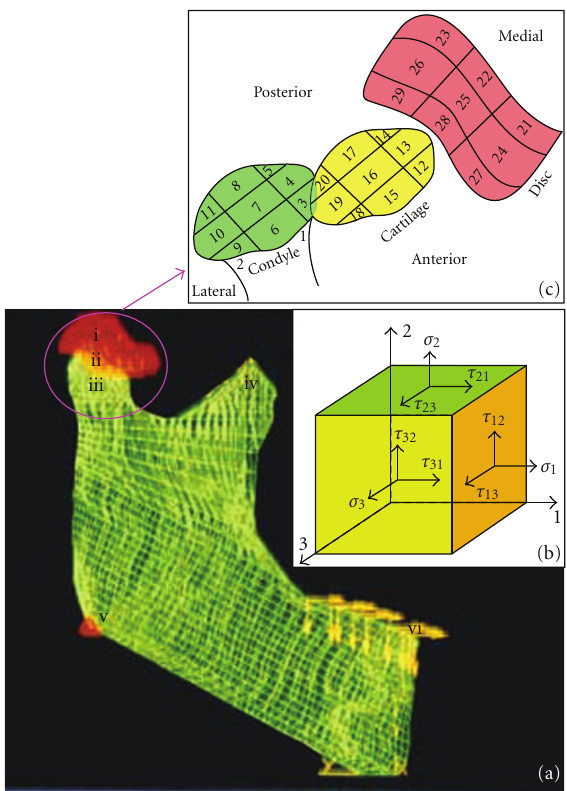
Figure 2: Finite element analysis model of temporomandibular joint (TMJ) stress. (a) Three-dimensional finite element mesh of the TMJ, including the mandible, disc (i), cartilage (ii), condyle (iii), and coracoid process (iv), with the mandible angle fixed (v) and alveolar ridge loaded by two-dimensional occlusal force vectors (vi). (b) State of stress in an orthotropic element. Each of the three material axes was assigned a value for the elastic modulus ( E ), and each of the three planes defined by those axes received values for the shear modulus ( G ) and Poisson’s ratio ( ν ). Thus, one principle stress ( σ ) and two shear stress ( τ ) values could be calculated from each plane of the element. 1, 2, and 3 indicate the same corresponding directions as in Figure 1. (c) Twenty-nine observation points map the TMJ for stress value